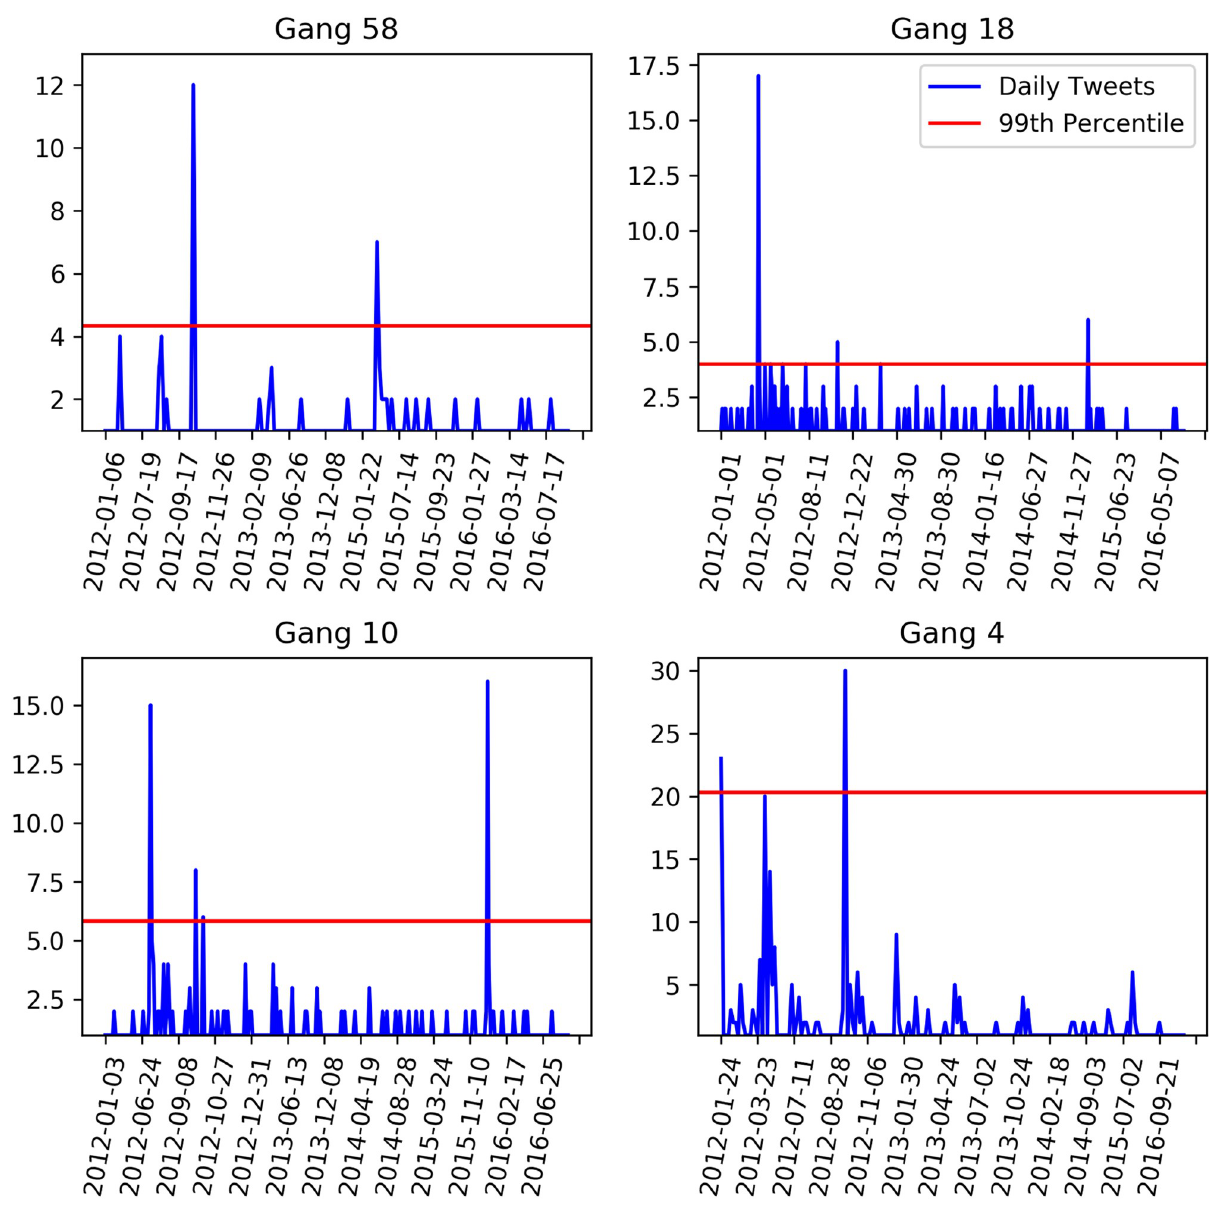
Fig 2. Standardized spikes for four sample gang territories/neighborhoods